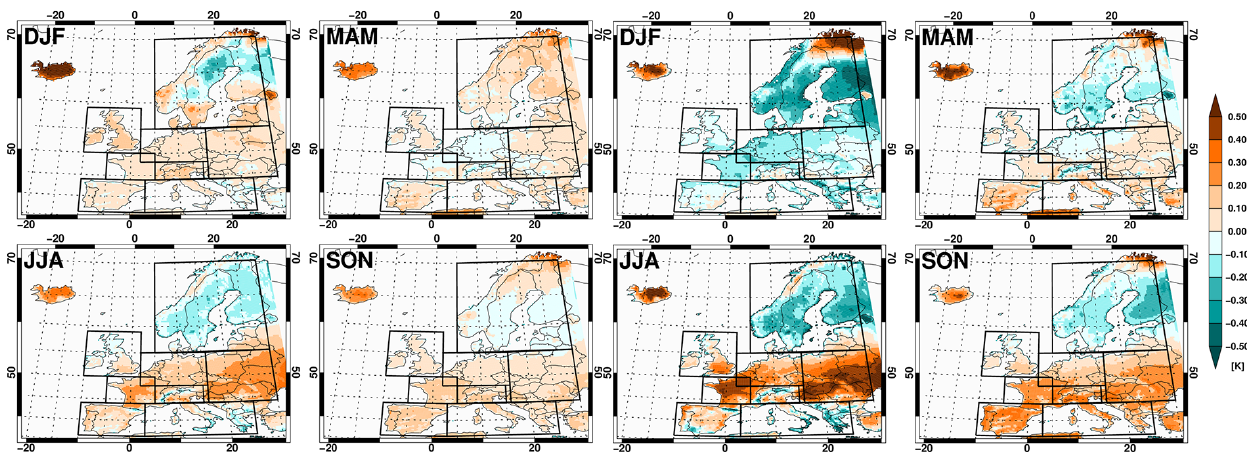
Figure 3. Differences between uncorrected and corrected (QM) multi-model standard deviation. The reference period is 1971–2000. The left panels refer to CCSs in the mid-21st century (2021–2050), the right panels to the end of the 21st century (2070–2099). Blue colors indicate areas where the uncorrected ensemble features a smaller standard deviation; orange colors vice